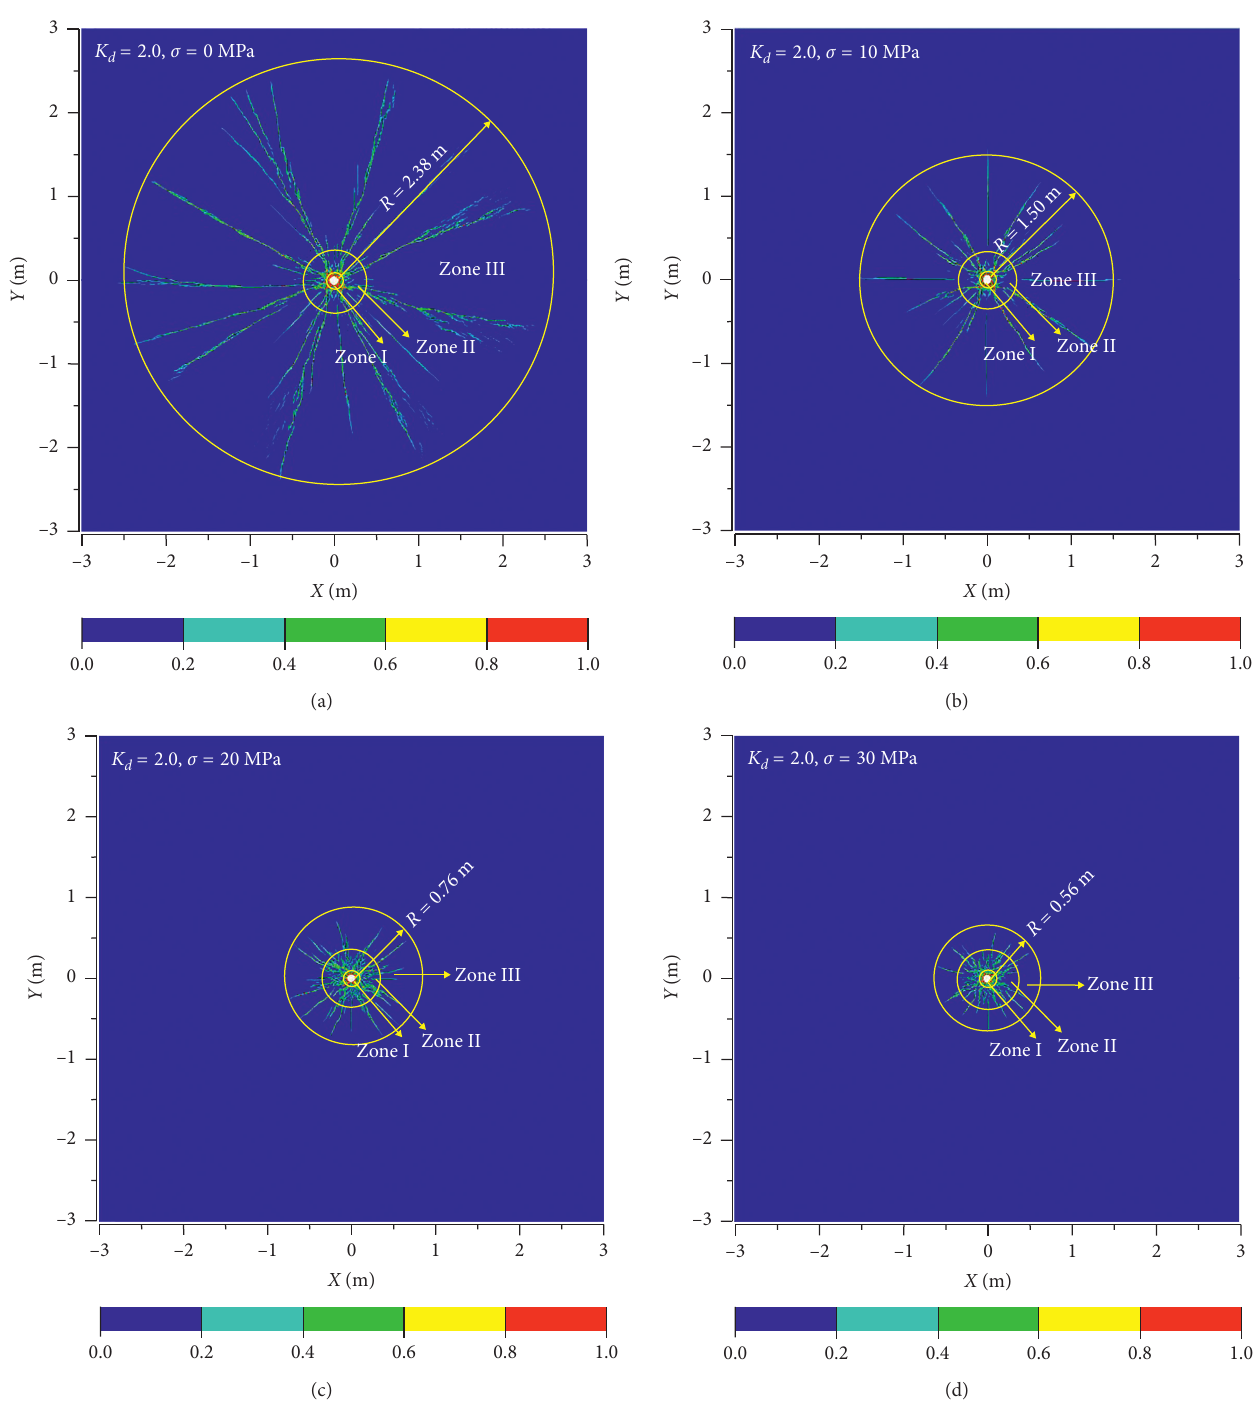
Figure 8: Crack patterns under different hydrostatic pressures ( K